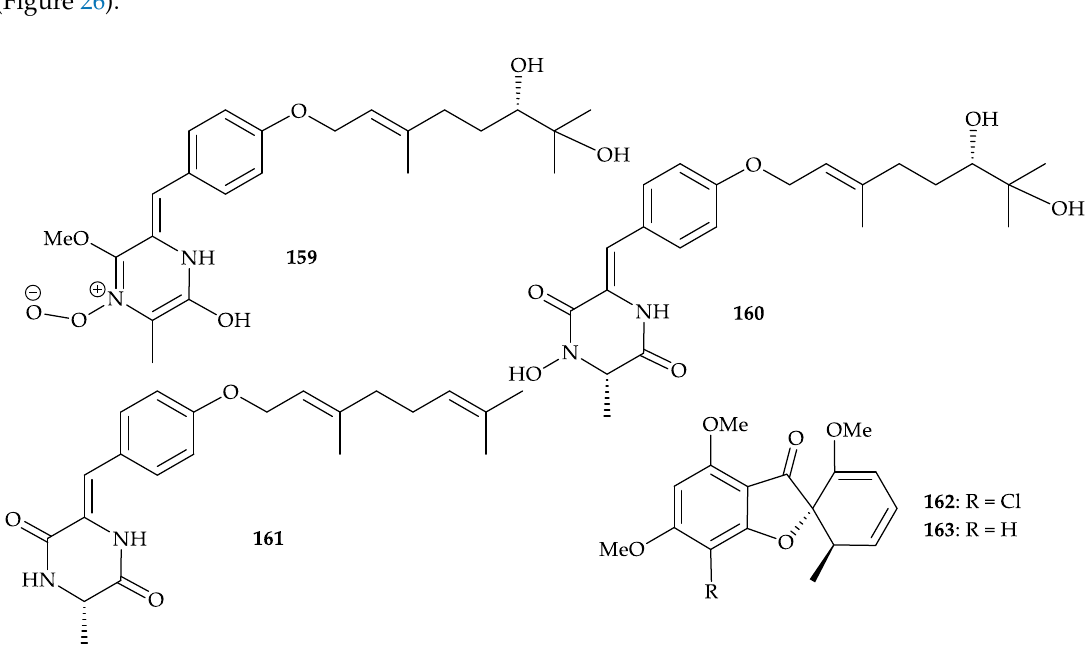
Figure 27. Structures of neoechinulin A ( 164 ), preechinulin ( 165 ), isoechinulin A ( 166 ), tardioxopiperazine A ( 167 ), variecolorin L ( 168 ), dihydroxyisoechinulin A ( 169 ), and L-alanyl-L- tryptophan anhydride ( 170 ).